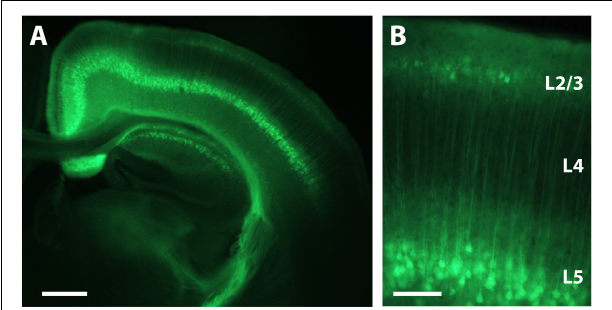
FIGURE 3 | Expression of GCaMP6s in L2/3 and L5 after P1 injection. (A) Coronal view of a section through the brain of a P16 mouse that was injected with rAAV-Syn_GCaMP6s at P1. Note the spread of the expression across the hemisphere and the abundant expression in L2/3 and L5, but not L4. Scale bar = 500 µ m. (B) Higher magnification image of GCaMP6s expression in L2/3 and L5. Scale bar = 100 µ